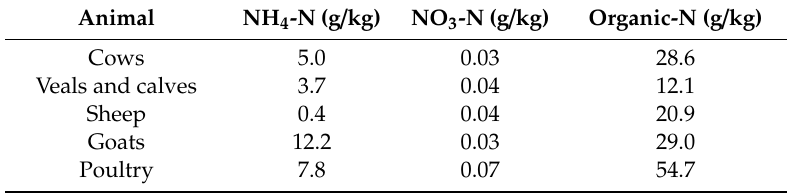
Table 3. The mass concentrations of the di ff erent nitrogen species in animals’ waste (g /